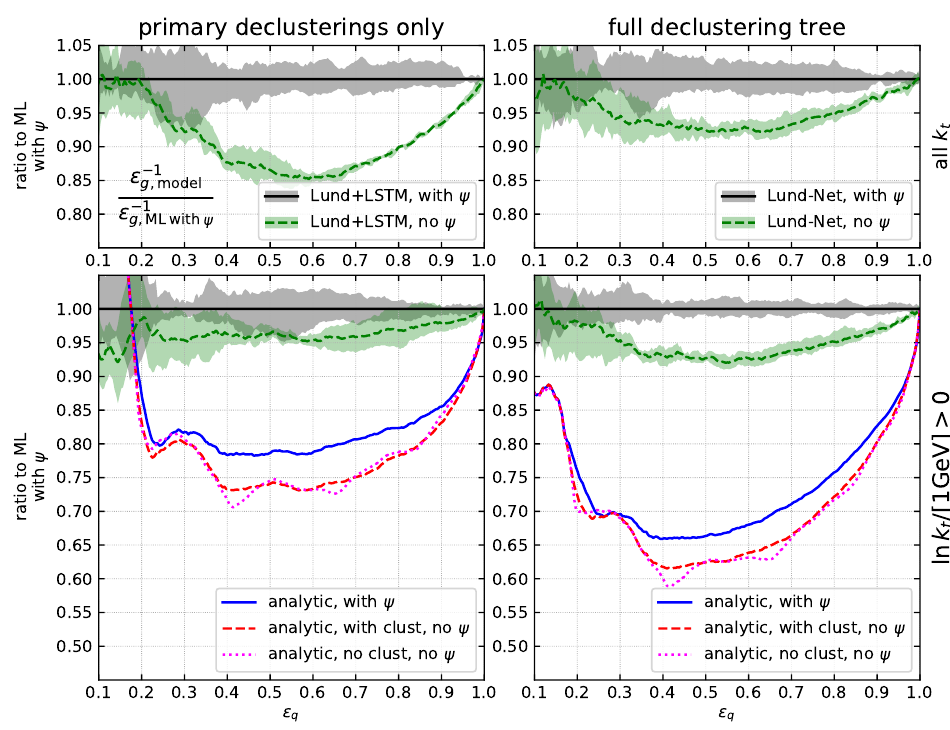
Figure 10. Plots showing the ratio of the ROC curve with and without azimuthal-angle dependence and/or clustering logarithms. The plots of the left column include only primary declusterings while the plots of the right column include the full declustering tree. The bottom plots include declusterings above a 1-GeV k cut, while the top plots include all relative transverse momenta. In t all cases, the ROC curve is normalised to the ML Results including azimuthal-angle